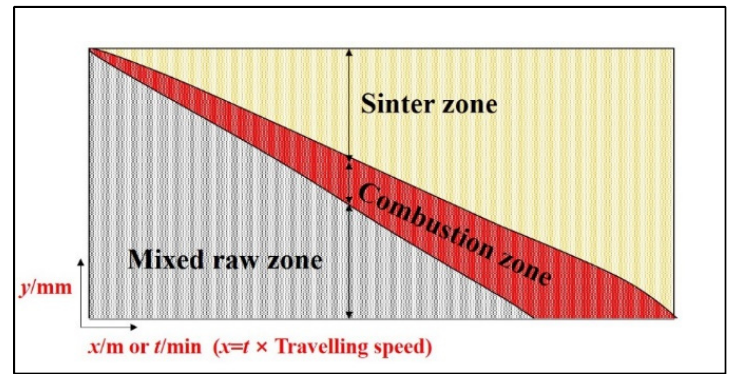
Figure 3. General zone of sintering bed in height and width direction.